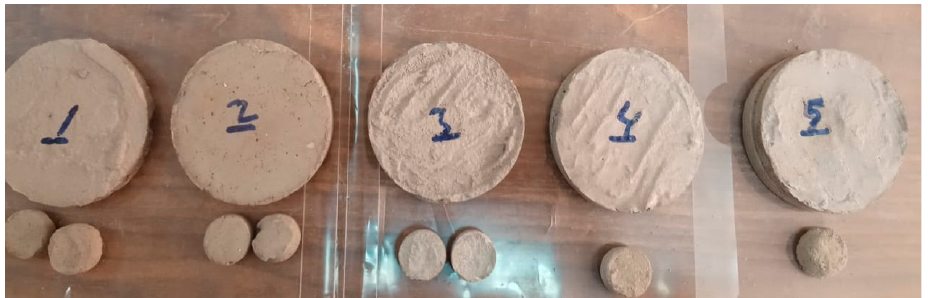
Figure 1. Picture of real prepared samples.